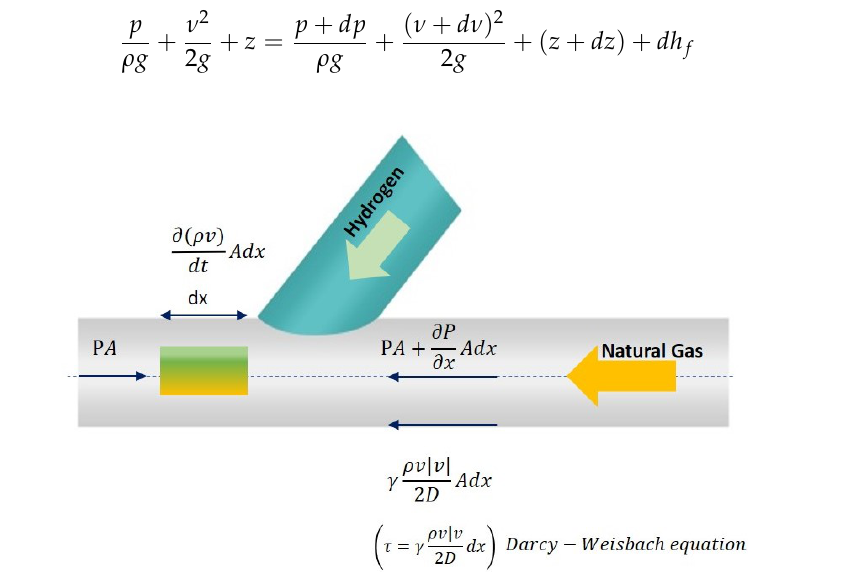
Figure 2. Effective forces on a specific volume of gas flow through a